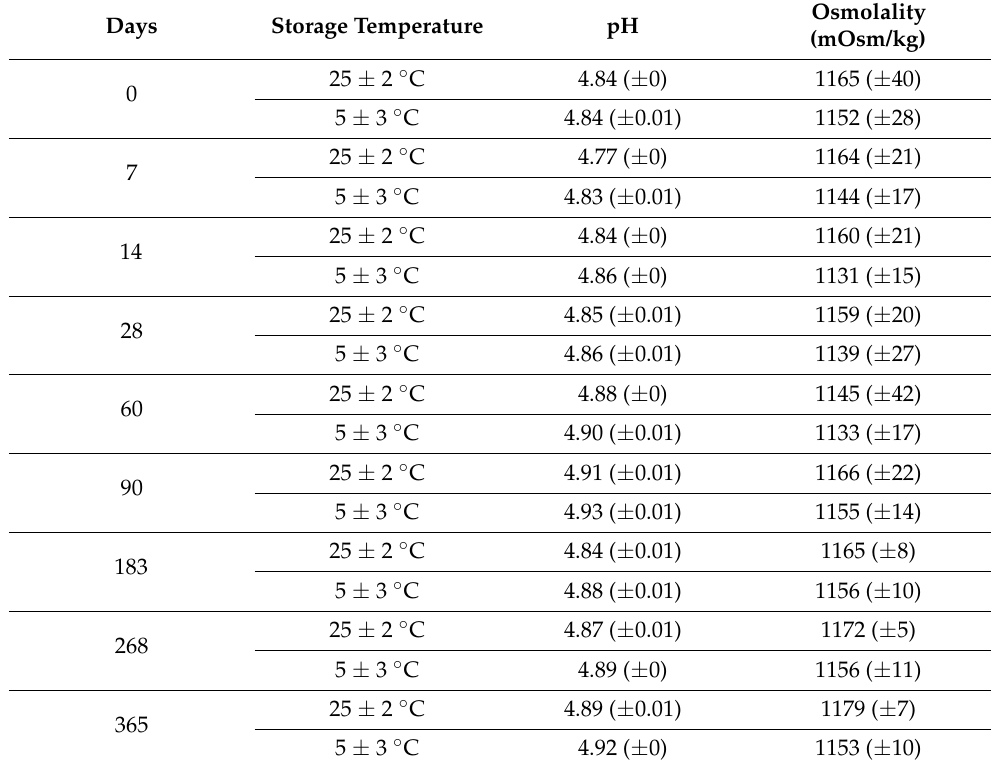
Table 5. Physical parameters of nicardipine hydrochloride 2 mg/mL assessed during the stability study.